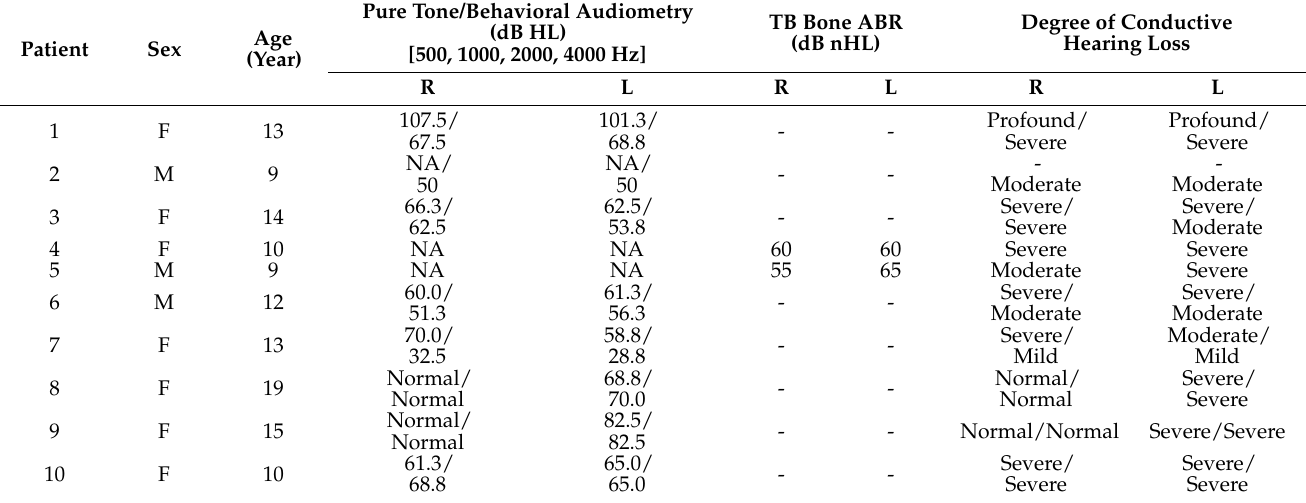
Table 1. Characteristics of 10 Patients with Microtia and Aural